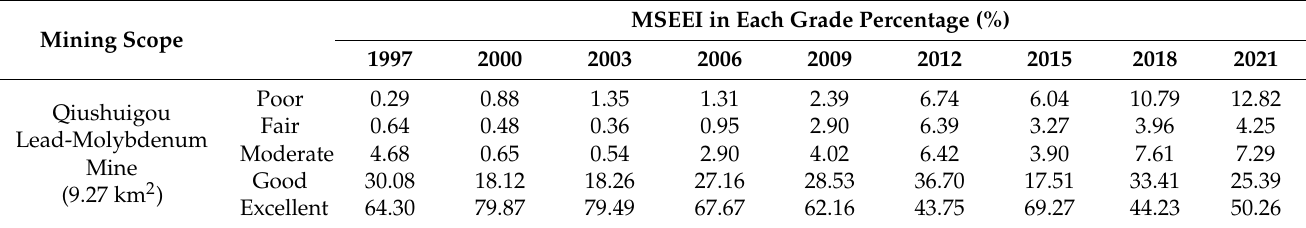
Table 3. MSEEI values in each grade percentage of mining